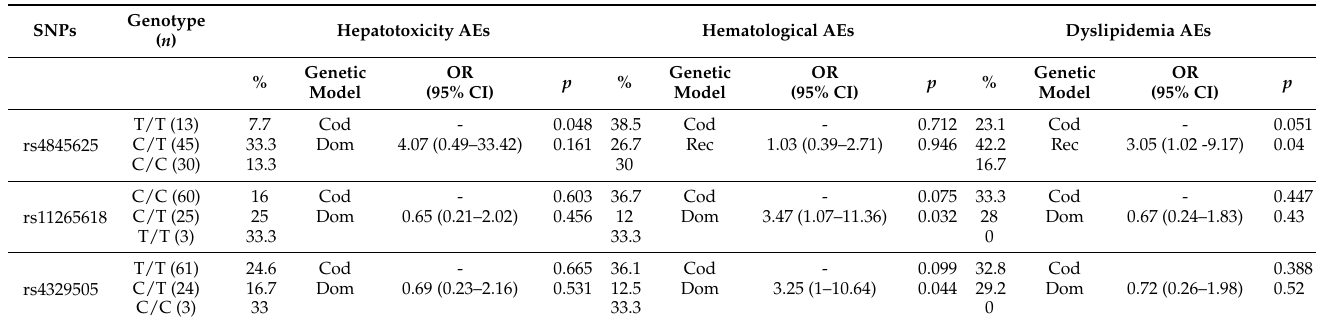
Table 4. Associations between rs4845625, rs11265618, and rs4329505 and hepatotoxicity, hematologi- cal, and dyslipidemia